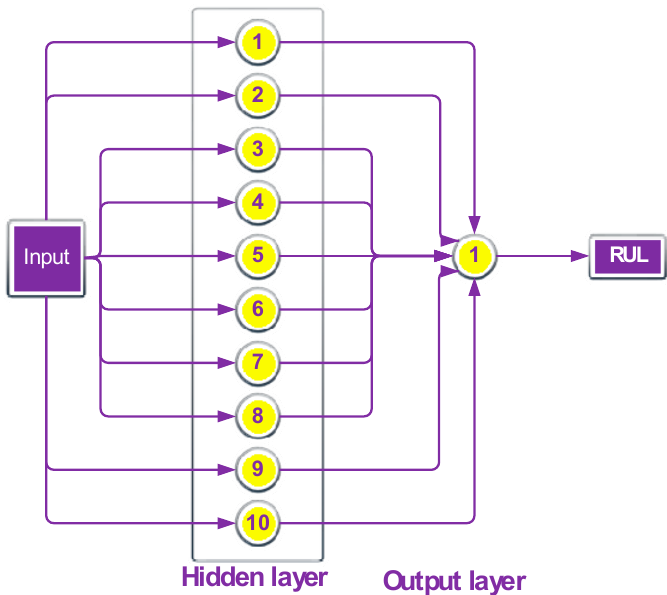
Figure 6. Structure of the proposed feedforward neural network (FFNN) for the remaining useful life (RUL) prediction task.